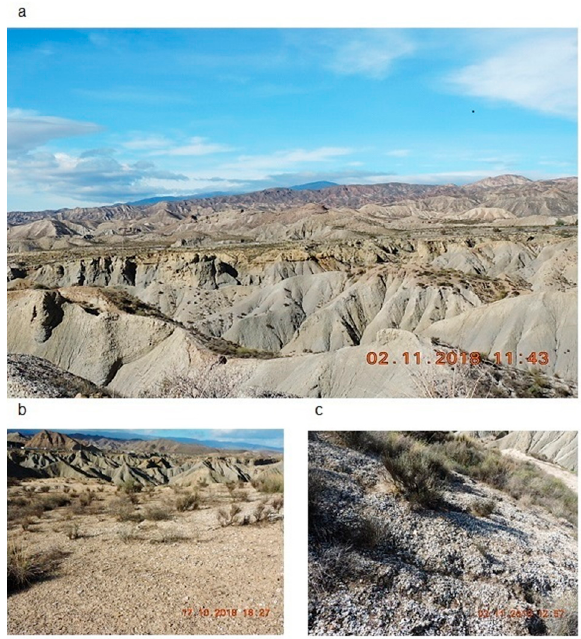
Figure 1. ( a ) A general view of the Tabernas basin, ( b ) sun-exposed plain and ( c ) north-oriented slope. Note the dominant white colors of lichens at the north-oriented slope.